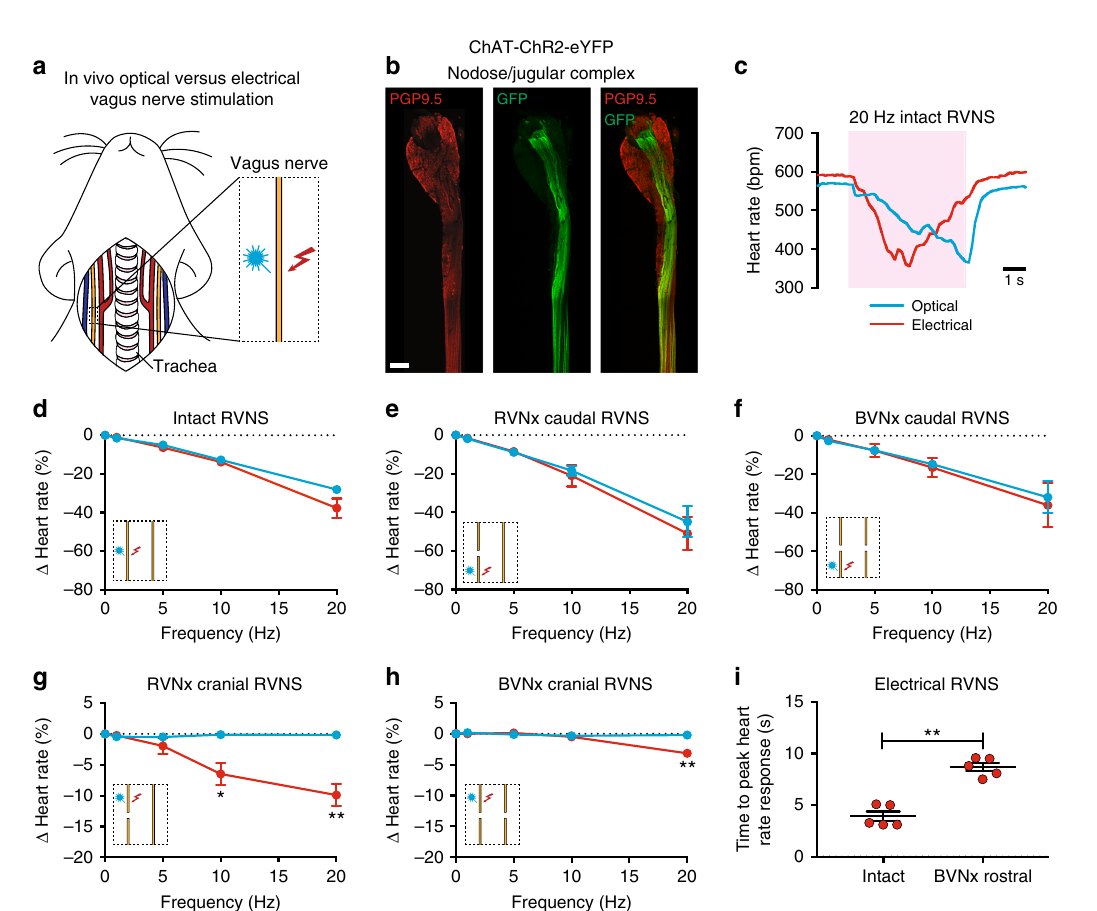
Fig. 4 In vivo optogenetic versus electrical stimulation of the vagus nerve. a Cartoon depicting optogenetic and electrical vagus nerve stimulation strategy in ChAT-ChR2-eYFP mice. The right vagus nerve was surgically exposed in anesthetized mice and either light or electricity was used for stimulation. b MIP images of the right nodose/jugular ganglion complex and vagus nerve whole-mount stained with PGP9.5 (red) and GFP (green). c Representative heart rate responses during optogenetic versus electrical right vagus nerve stimulation (RVNS; magenta shading) at identical frequencies (20 Hz) and pulse widths (10 ms) in the intact state. The light pulse power for optogenetic stimulation was 57 mW and the current for electrical stimulation was 5 µ A. d Frequency response curves summarizing the effects of optogenetic versus electrical RVNS on heart rate in the intact state. e , f Frequency response curves summarizing the effects of optogenetic versus electrical RVNS of the caudal end on heart rate following right vagotomy (RVNx) ( e ) and bilateral vagotomy (BVNx) ( f ). g , h Frequency response curves summarizing the effects of optogenetic versus electrical RVNS of the cranial end on heart rate following RVNx ( t 4 = 3.576, * P = 0.0232 at 10 Hz; t 4 = 5.229, ** P = 0.0064 at 20 Hz) ( g ) and BVNx ( t 4 = 8.588, ** P = 0.0010 at 20 Hz) ( h ). In d – h insets show a schematic of the stimulation protocol. i The time to peak heart rate response during electrical RVNS in the intact state versus of the cranial end following BVNx ( t 4 = 6.335, ** P = 0.0032). n = 8 mice ( d ), three mice ( e , f ), and fi ve mice ( g , h , i ); mean ± s.e.m.; paired, two-tailed t -test. Scale bar is 200 µ m ( b